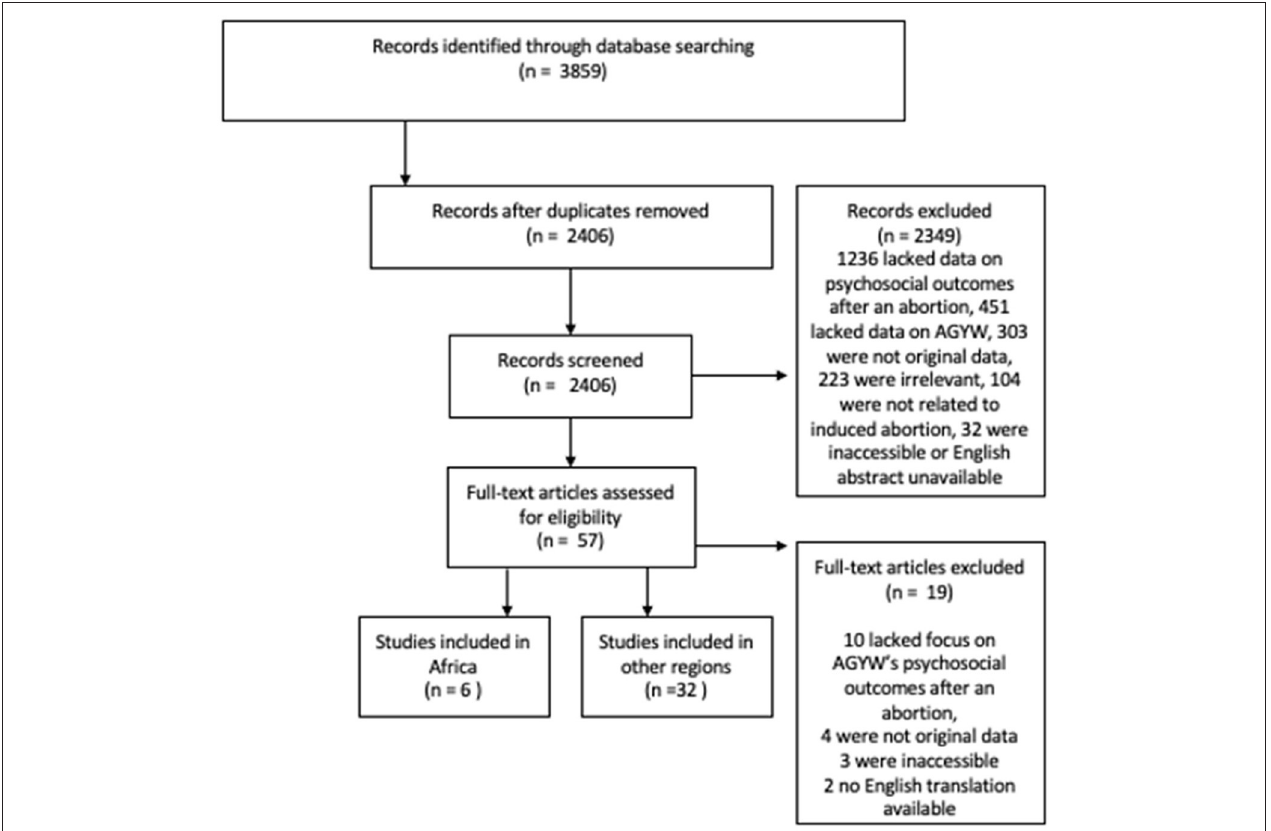
FIGURE 1 | PRISMA flow